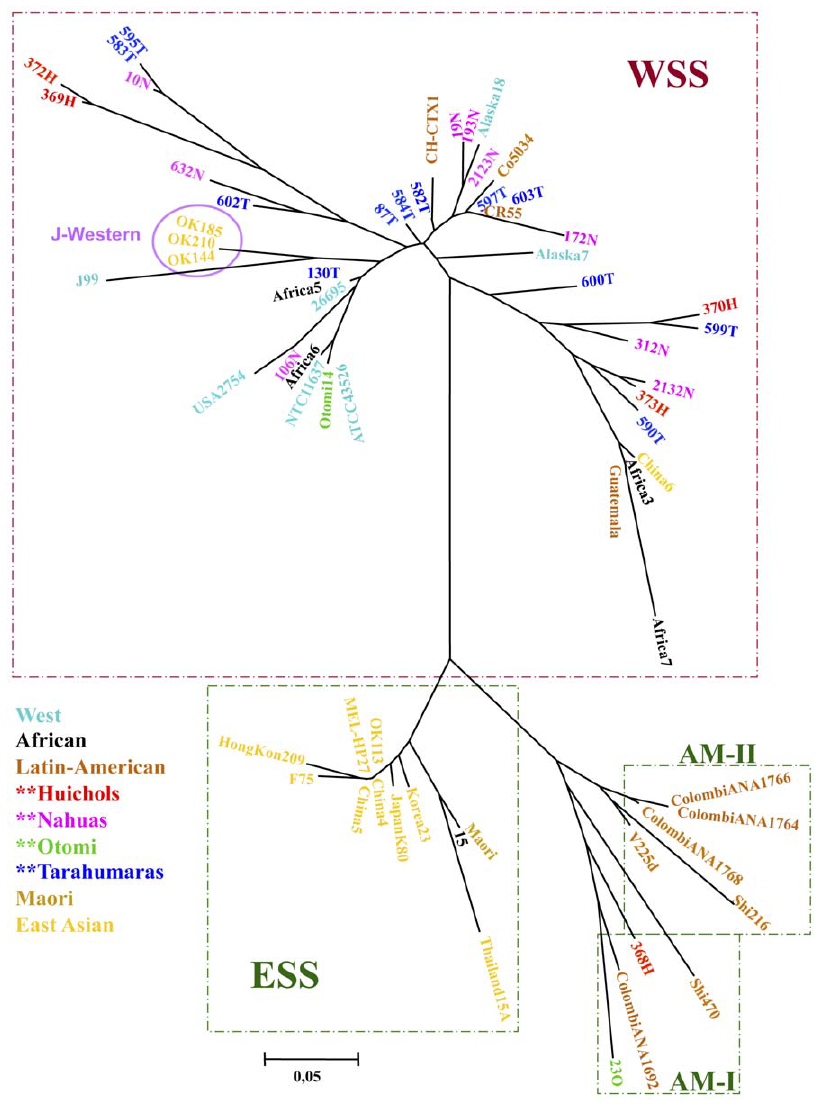
Figure 2. Phylogenetic analysis of sequences of vacA of H.pylori strains from Mexican native groups. The trees were constructed by the Neighbor-joining method based on Kimura’s two-parameter model distance matrices. Phylogenetic analysis of vacA signal sequence shows most sequences clustered in the s1b group, whereas the Otomi 23O strain together with some Colombian isolates grouped between s1a and s1b. The Huichol 368H grouped close to the s1C branch, together with some Alaskan and Colombian